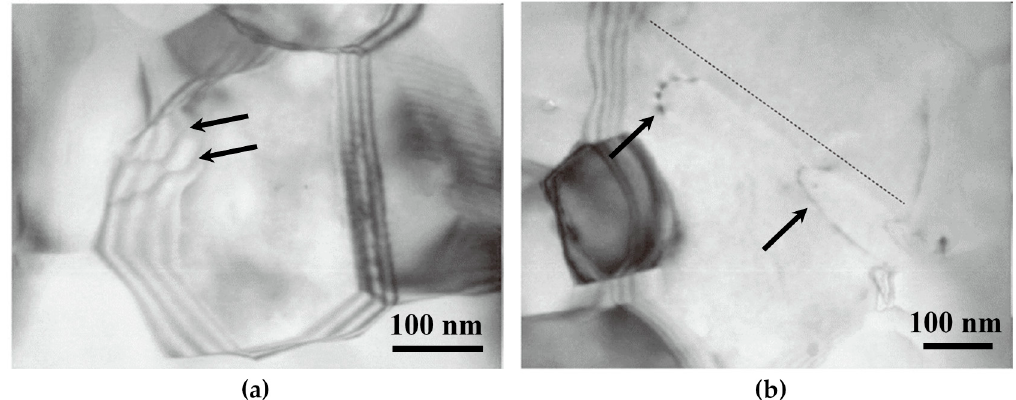
Figure 15. The dislocation–grain boundary interaction in an ultrafine-grained Al at different strains. ( a ) The dislocations move inside a grain boundary at a low strain; ( b ) The dislocations emit into the grain interior at a relatively high strain. (Reprinted from Reference [42], with permission from Elsevier).